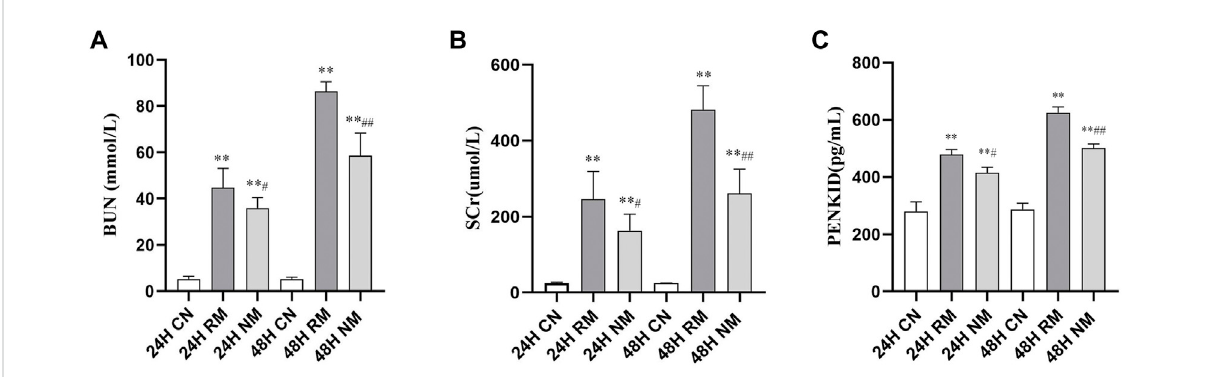
FIGURE 2 Effect of NM on serum levels of pro-in fl ammatory cytokines and PENKID. (A) The effect of NM on glycerol induced changes in IL-6. (B) The effect of NM on glycerol induced changes in TNF- α . (C) The effect of NM on PENKID (* p < 0.05, and ** p < 0.01 vs. CN; # p < 0.05, and ## p < 0.01 vs. RM).